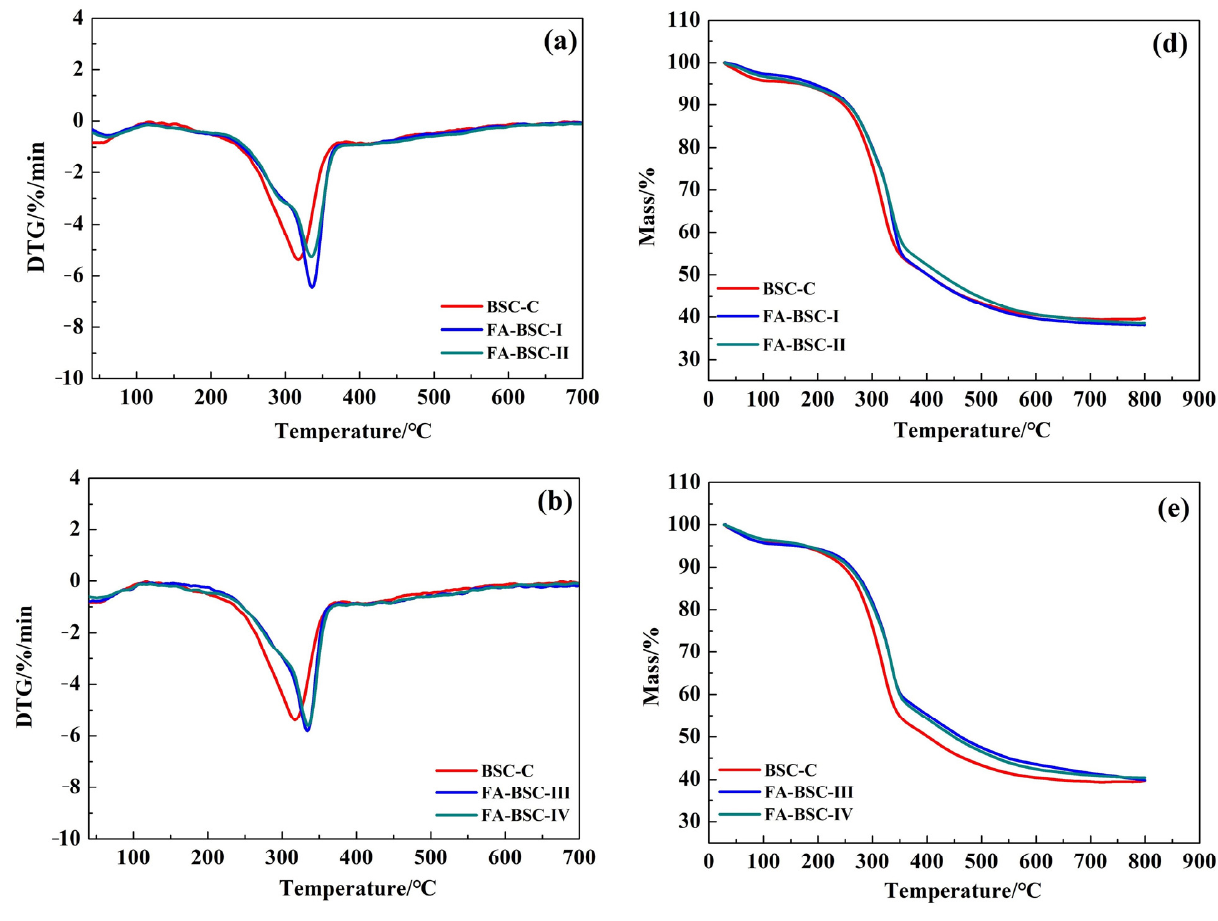
Figure 7. Thermogravimetric analysis of untreated BSCs and furfurylated BSCs. ( a , d ) from BSC-C, FA-BSC-I and FA-BSC-II; ( b , e ) from BSC-C, FA-BSC-III and FA-BSC-IV; ( c , f ) from BSC-C, FA-BSC- V and